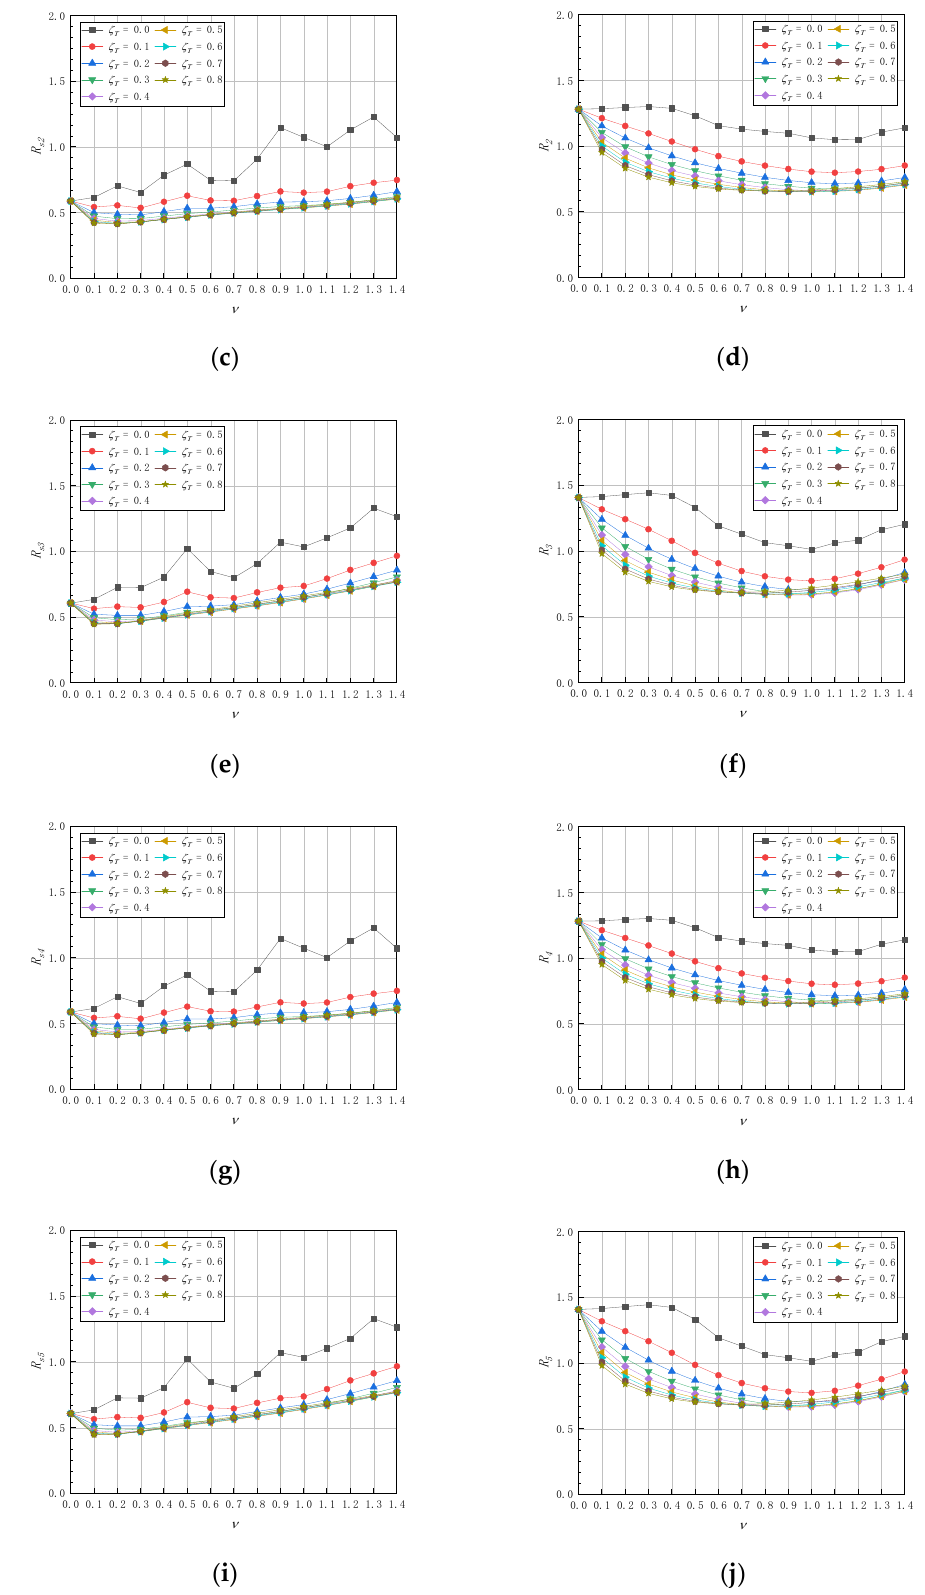
Figure 10. Responses of the ( a , c , e , g , i ) 1st, 2nd, 3rd, 4th and 5th story of the substructure and ( b , d , f , h , j ) main structure of a five ‐ story building.